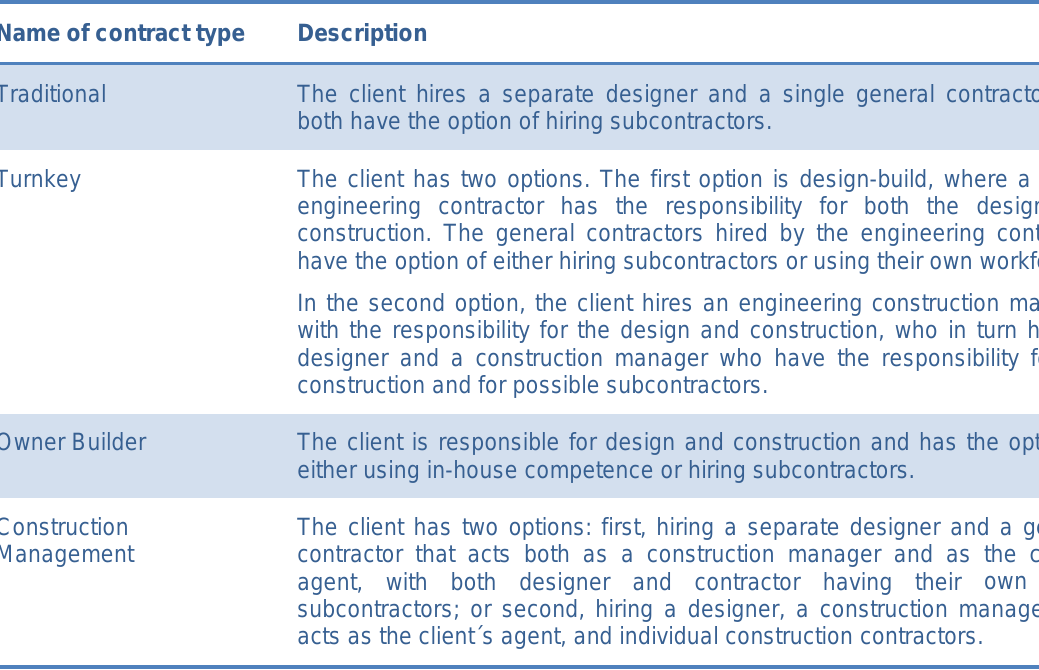
Table 3: Contract structure in Ritz and Levy (2013, Ch. 2)